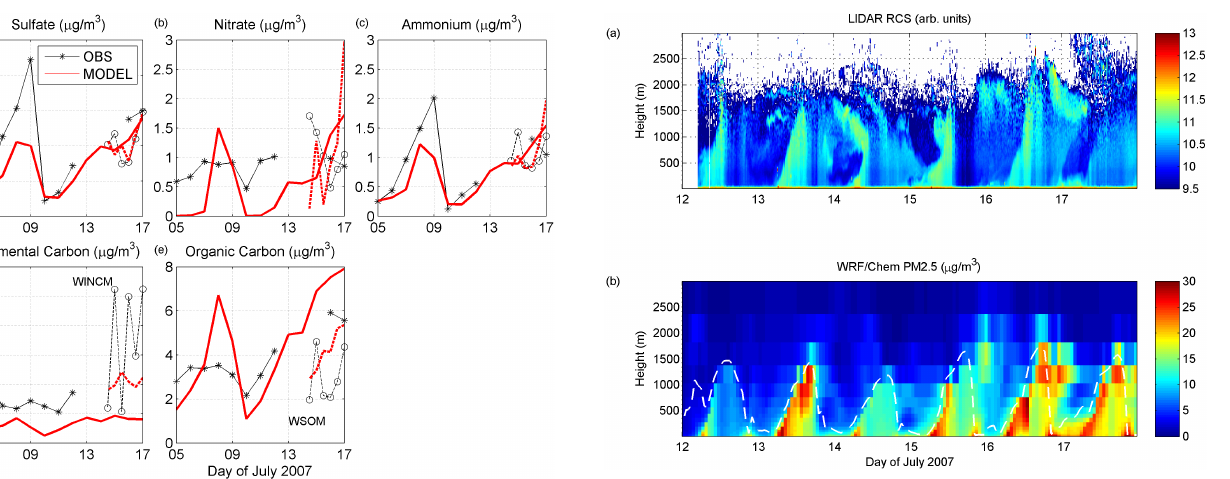
Figure 5. Same as Fig. 2, for daily (solid lines) and twice-daily (dashed lines) particulate-matter composition at ground level in Mi- lan on 5–17 July 2007. Twice-daily observations (dashed lines) are available only from 14 to 17 July. In panel (d) , WINCM is the water-insoluble carbon mass (EC + mostly primary OC); in panel (e) WSOM is water-soluble organic mass (mostly secondary or- ganic aerosol; Carbone et al., 2010).